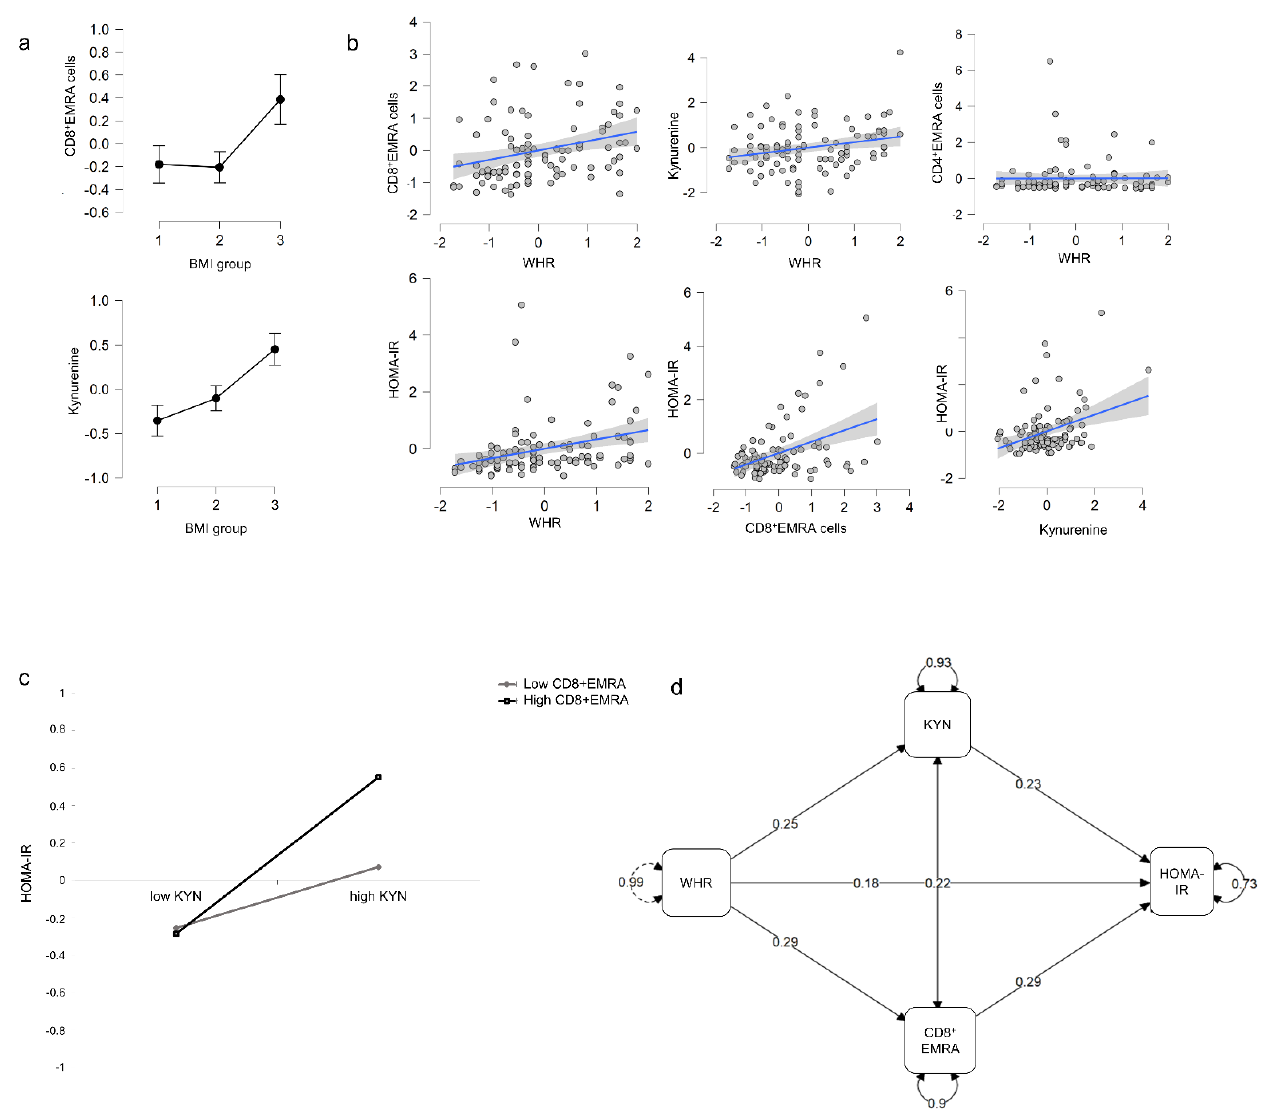
Figure 4. ( a ) Proportion of CD8+EMRA cells and KYN in BMI group 1 (BMI 18.5–24.9 kg/m 2 ), group 2 (BMI 25–29.9 kg/m 2 ), and group 3 (BMI > 30 kg/m 2 ). ( b ) Correlations between WHR and the proportion of CD8+EMRA cells, WHR and KYN, WHR and proportion of CD4+EMRA cells, WHR and HOMA-IR, CD8+EMRA and HOMA-IR, as well as KYN and HOMA- IR. ( c ) Associations between low/high kynurenine levels, levels of CD8+EMRA cells, and HOMA-IR. ( d ) Interaction of WHR on HOMA-IR mediated by CD8+EMRA cells as well as by KYN. Furthermore, a significant covariation between KYN and CD8+EMRA is demonstrated.